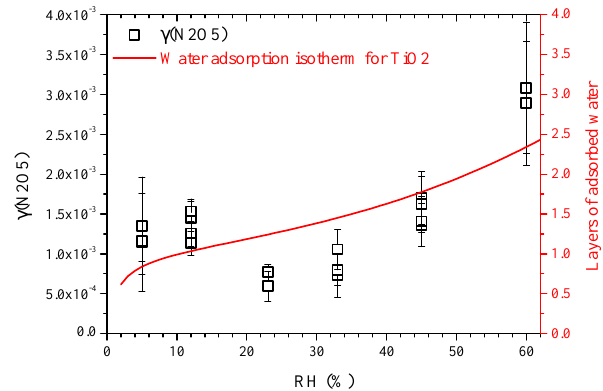
Figure 4. Uptake coefficients of N 2 O 5 onto airborne TiO 2 parti- cles (black squares, left x axis) at different relative humidities. The number of layers of the adsorbed water on TiO 2 particles (red curve, right y axis) at 296K, measured by transmission FTIR spectroscopy (Goodman et al., 2001), is also plotted as a function of